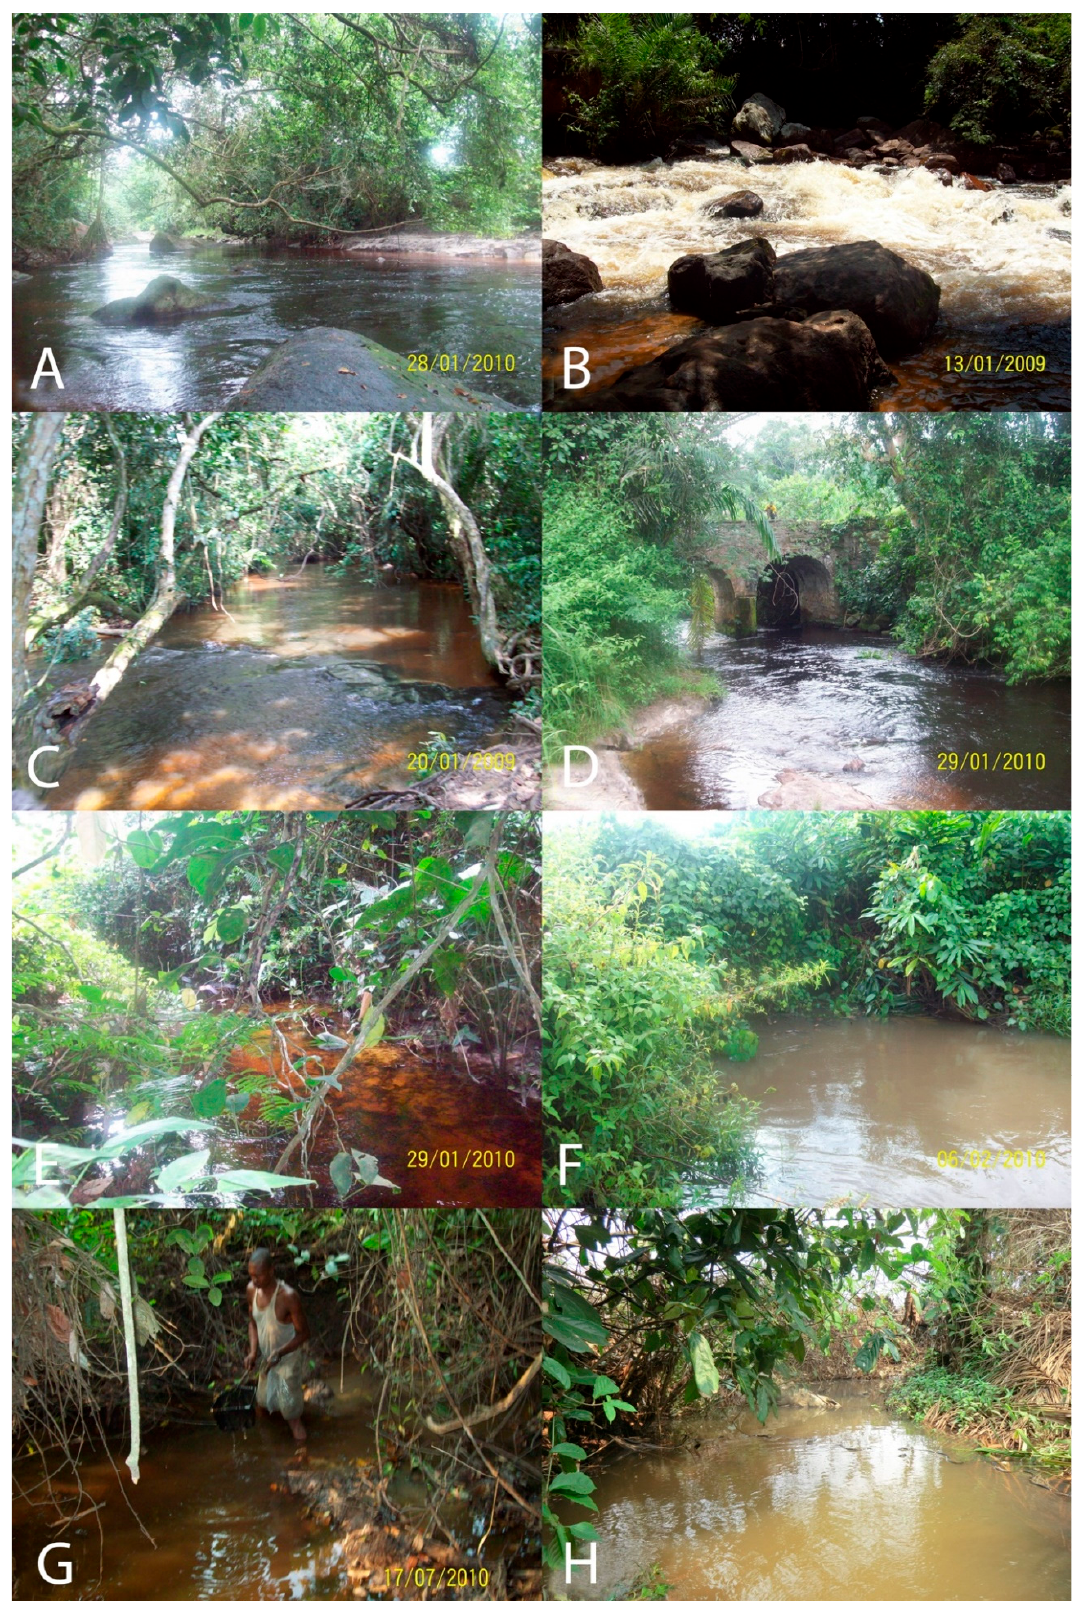
Figure A2. Biotopes of collection sites located in tributaries and sub-tributaries of the LR: ( A ) Lubi River (Site 24); ( B ) Luna River (Site 39); ( C ) Luyenga River (Site 28); ( D ) Tshimayi River (Site 31); ( E ) Mikindimbua River (Site 30); ( F ) Mukundulu River (Site 42); ( G ) Kabikonyi River (Site 41); ( H ) Tukomba River (Site 17).